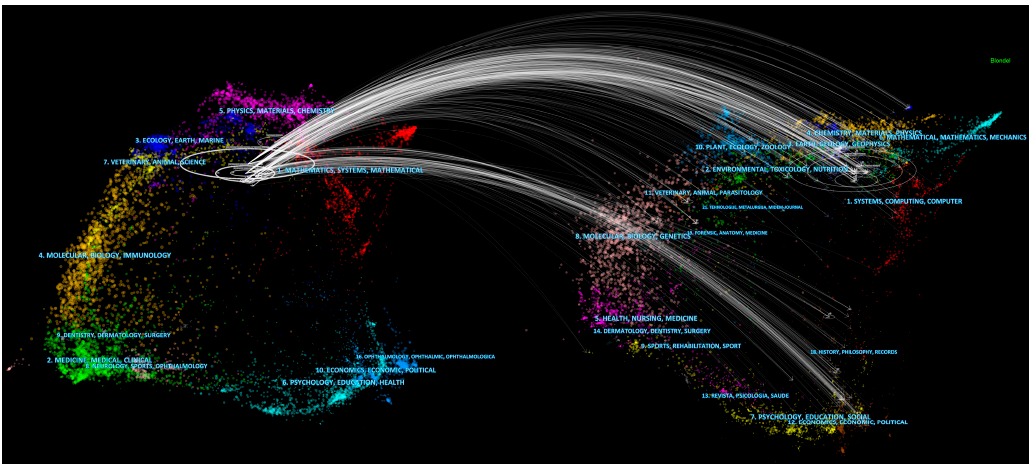
Figure 14. NTL remote sensing distribution in a global science dual-map.